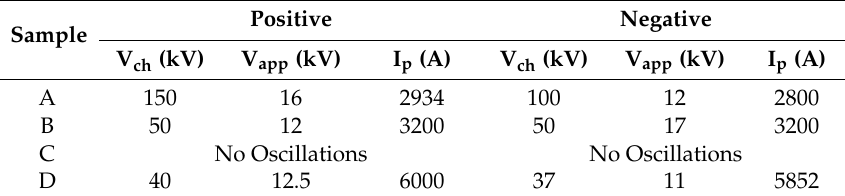
Table 3. Levels of Charging Voltage (V ch ), Applied Voltage (V app ) and Peak Current (I p ) at which Oscillation Starts to Appear on the Current Trace.